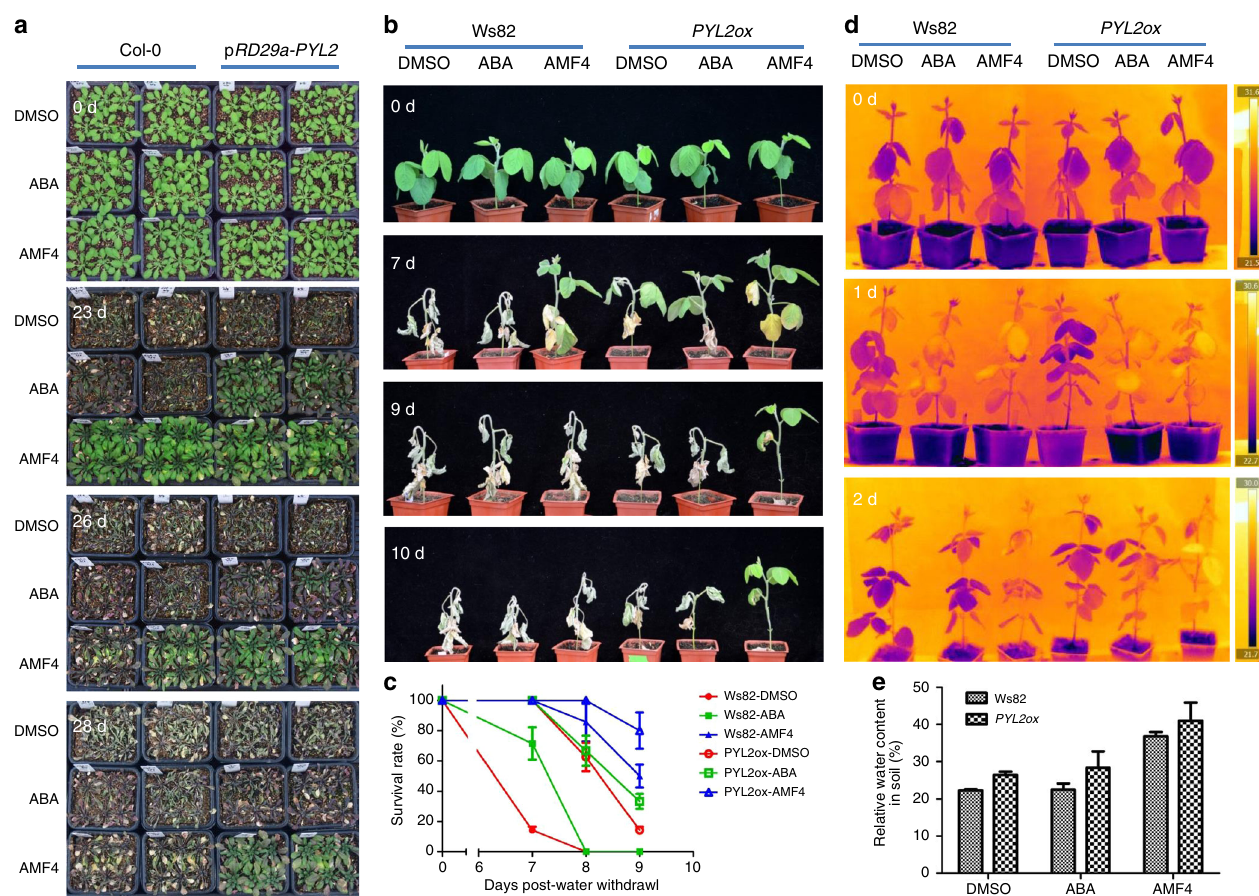
Fig. 7 The combining of chemical and genetic approaches provides the highest drought resistance. a Additive effects of AMF4 and stress-induced PYL2 expression in enhancing drought resistance in Arabidopsis . Wild-type plants (Col-0) and transgenic plants transformed by Arabidopsis RD29a promoter- driven PYL2 (p RD29a - PYL2 ) are grown under short-day conditions for 2 weeks before watering is stopped. The plants are subsequently treated with DMSO (control) or 10 μ M (+)-ABA or AMF4 once per week for another 2 weeks. The plants are photographed before treatment (0d) and at 23, 26 or 28 days after fi rst chemical treatment. b – e Additive effects of AMF4 and stress-induced PYL2 expression in enhancing drought resistance in soybean. b Wild-type (Ws82) and transgenic plants transformed by RD29a promoter-driven PYL2 ( PYL2ox ) at the triple trifoliate stage are subjected to drought (watering was stopped) and are treated every 3 days with DMSO (control), 50 μ M (+)-ABA, or 50 μ M AMF4 for 9 days before watering is resumed. The plants are photographed before watering is stopped (0 days) and 7, 9, and 10 days after watering is stopped. c Survival rates are calculated daily from the 7th